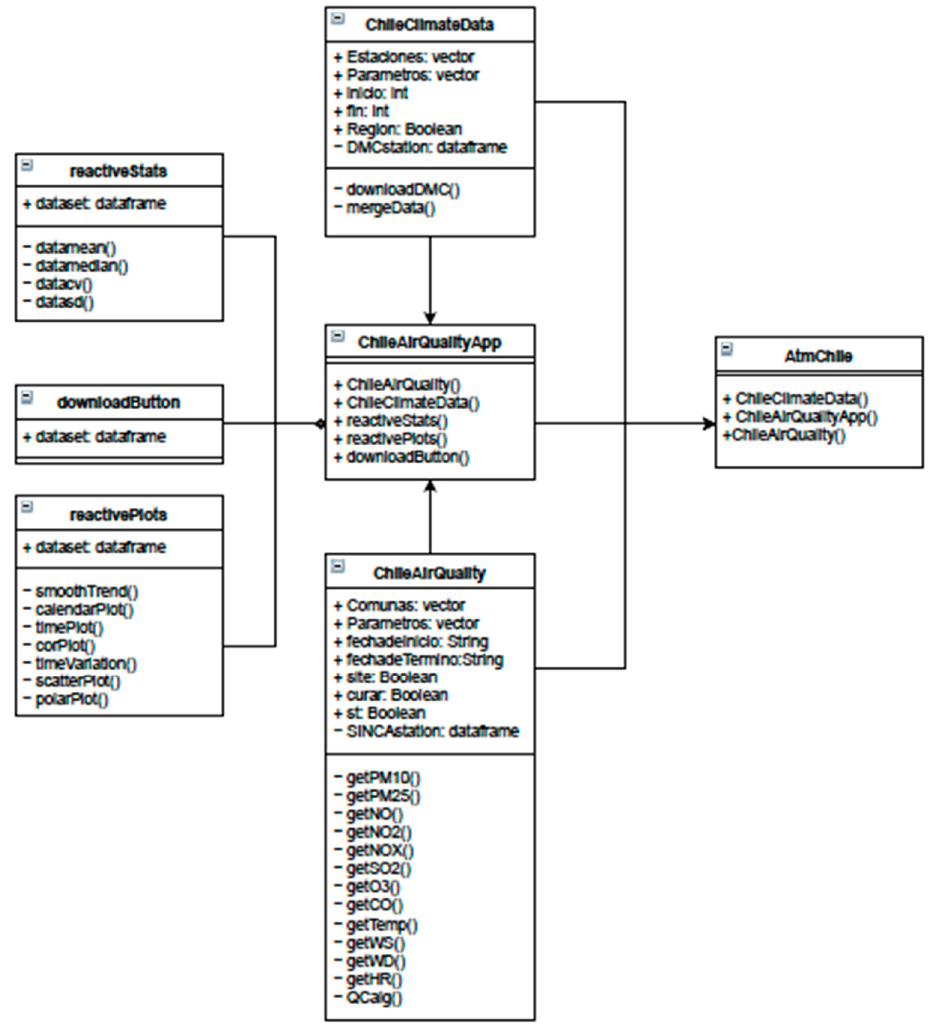
Figure 2. Unified Modeling Language (UML) class diagram of the AtmChile R package.